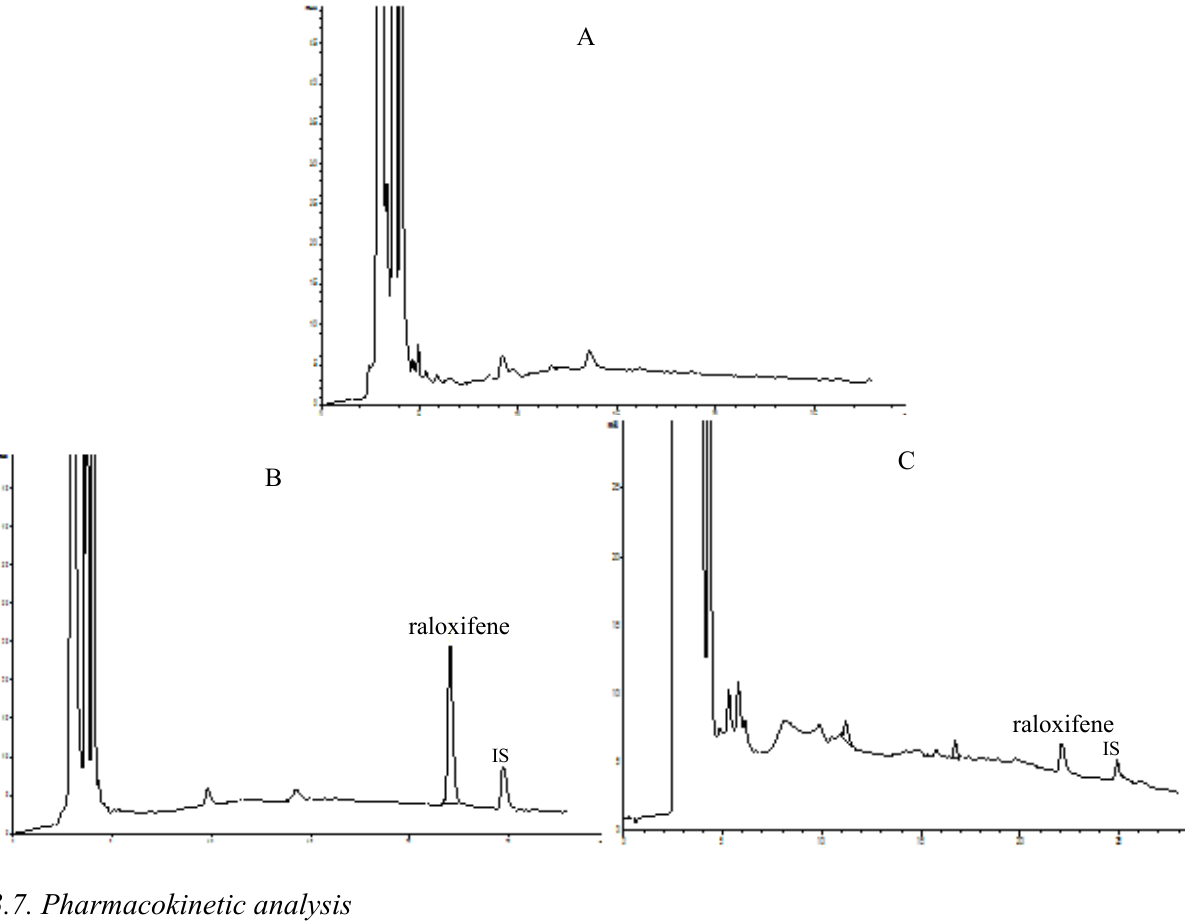
Figure 3. Representative chromatograms of raloxifene. (A) blank plasma; (B) plasma spiked with raloxifene and internal standard (testosterone); (C) plasma sample obtained 4 h after oral administration of